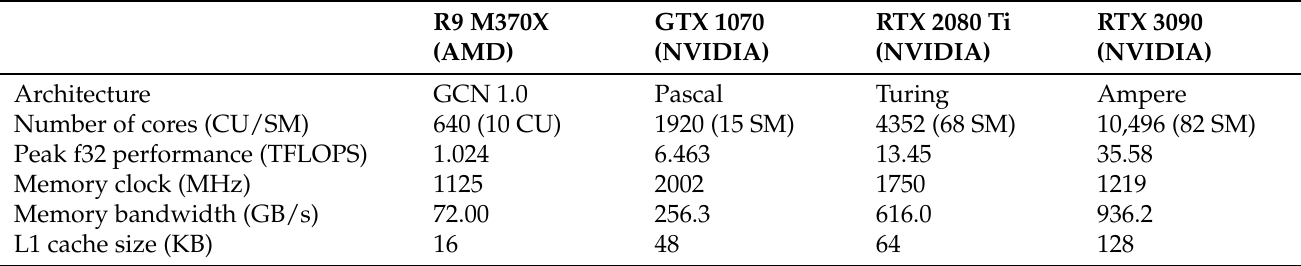
Table 1. Hardware specifications for GPUs used for testing the simulation software described in this paper (taken from https://www.techpowerup.com/gpu-specs/ accessed on 15 February 2021), where SM—streaming multiprocessor and CU—computing